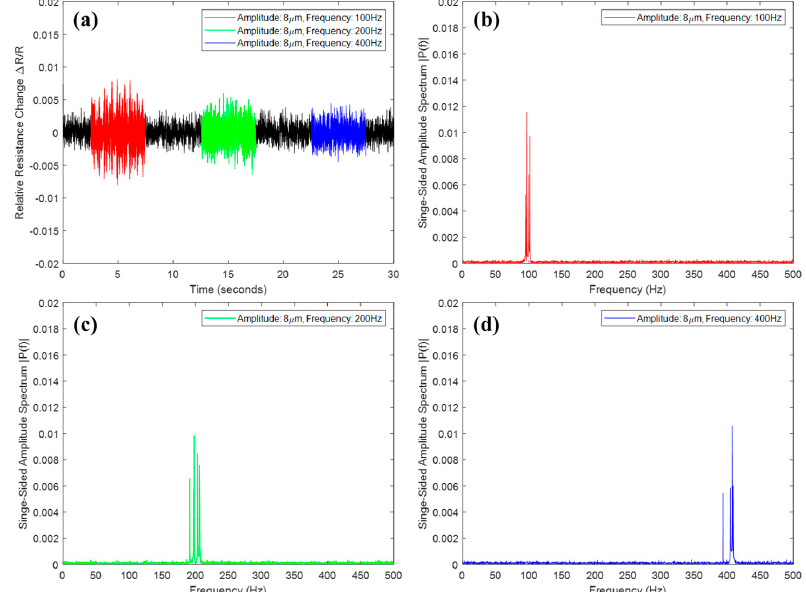
Figure 4. Experimental results according to the vibration frequency. ( a ) Relative resistance change, amplitude spectrum of ( b ) 100 Hz, ( c ) 200 Hz, and ( d ) 400 Hz.